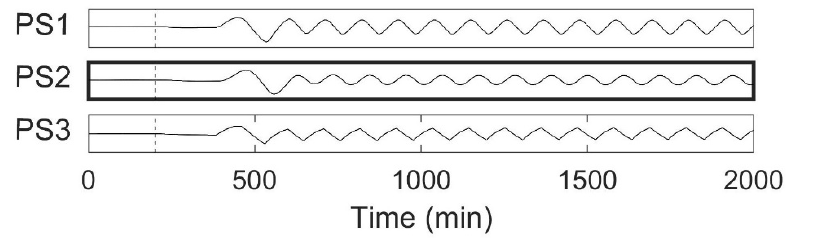
Figure 5. Time series for the first principal component of each PS with and without valve stiction on line FI 203 located in PS2 (indicated with a bold border). The vertical dashed line indicates the beginning of the valve stiction.